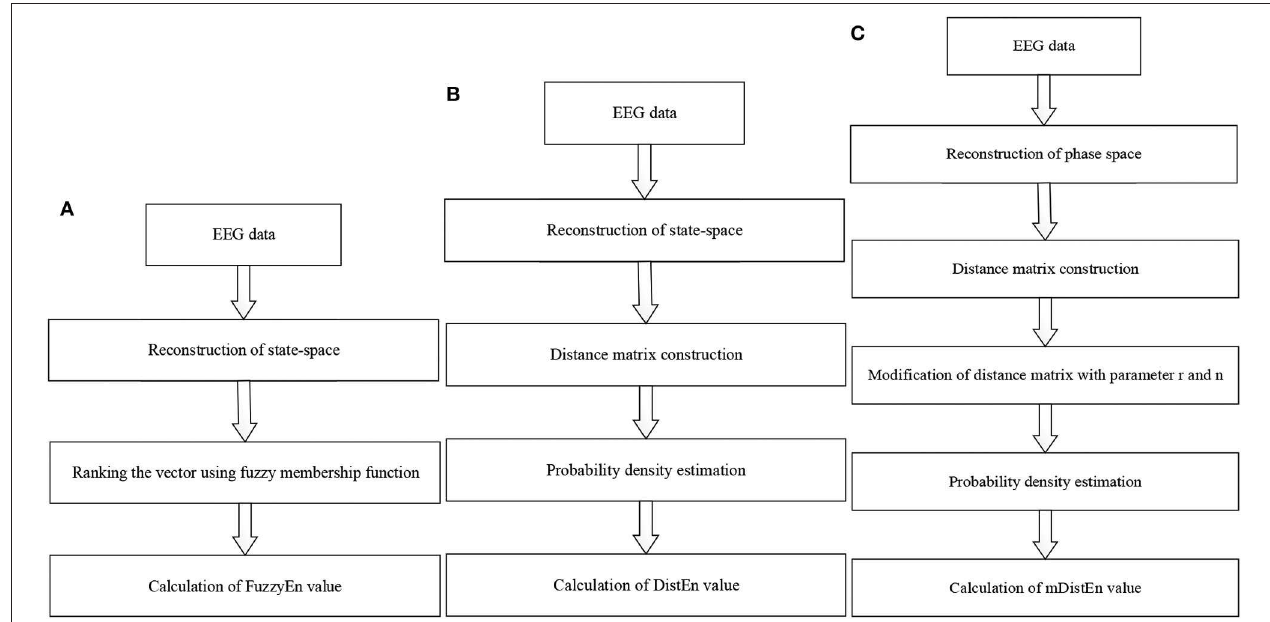
FIGURE 2 | Flow diagrams for calculating the entropy values. (A) Fuzzy entropy calculation; (B) distribution entropy calculation; and (C) modified-distribution entropy